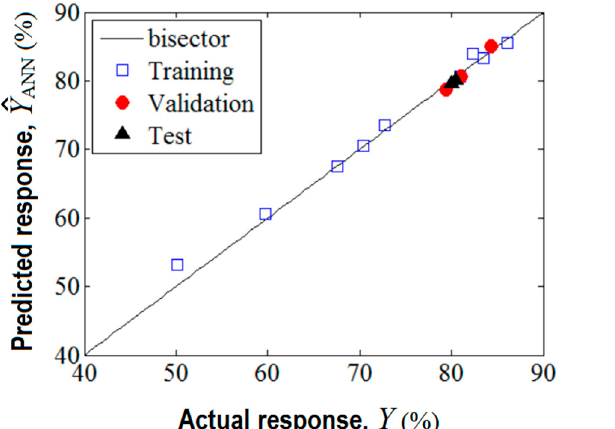
Figure 4. Feed-forward ANN architecture [2:3:1] developed to predict the removal efficiency of nitrite ions from aqueous solutions by using the adsorption-ultrafiltration hybrid process.